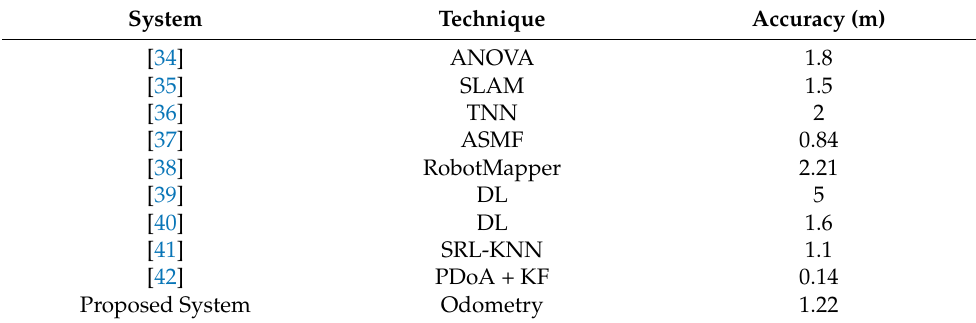
Table 5. Auto-fingerprinting